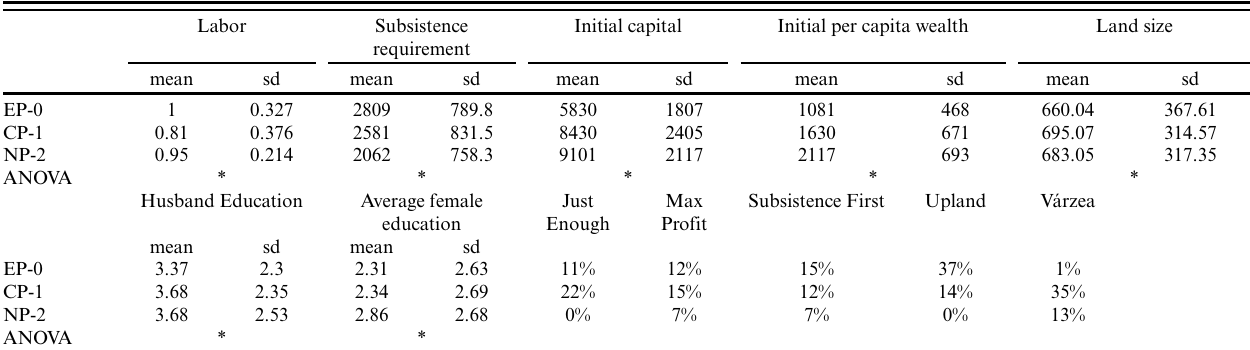
Table 4 . Initial household characteristics among households that end up in different livelihood states. Note: EP = extreme poverty, CP = chronic poverty, and NP =